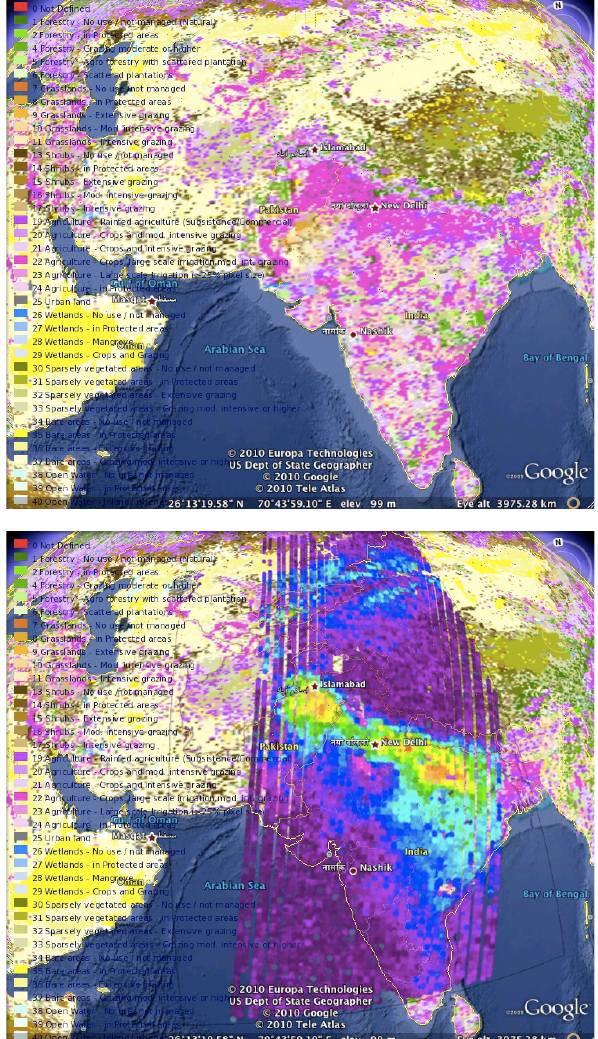
Fig. 12. Ammonia as seen by IASI across Asia for the morning overpass on 13 May 2008 using the new filter. The top panel shows a map of landuse, where pink and purple colours correspond to agri- culture, green colours correspond to sparsely vegetated or forested areas, and yellow colours correspond to bare areas. Bottom panel shows ammonia overlaid onto the landuse map. Individual IASI pixels are larger than true